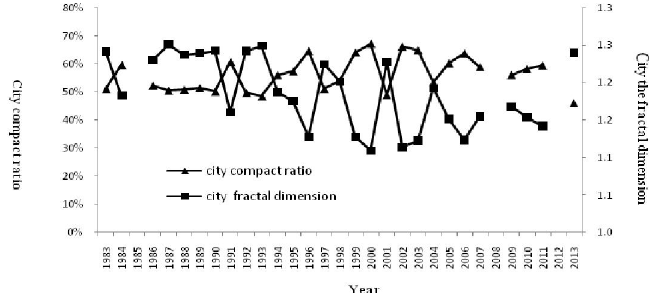
Figure. 9 Temporal variation of the city compact ratio and the fractal dimension between 1986 and 2010,Haidian District 4.3 COMPOSITE STATISTICAL INDEXES 4.3.1 Land cover suitability